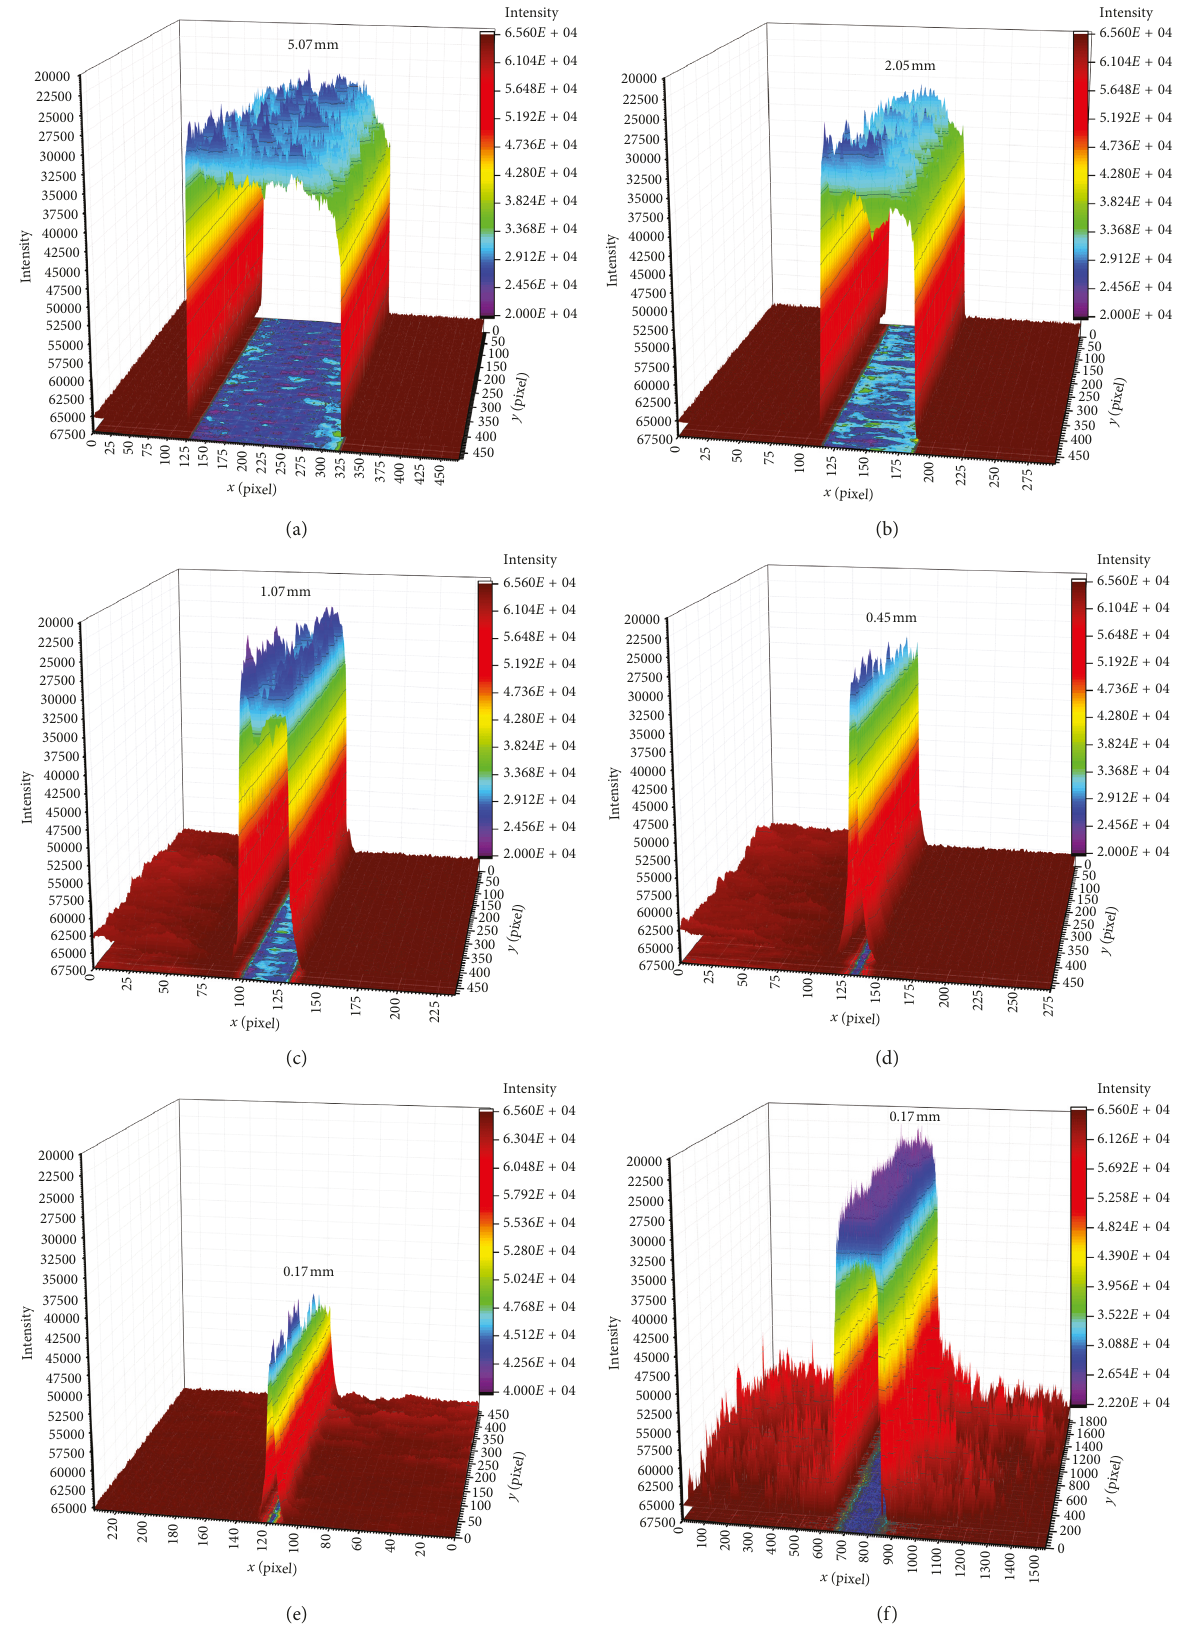
Figure 3: 3D plotting of the intensity distributions corresponding to the caliper’s gap sizes of (a) 5.07mm, (b) 2.05mm, (c) 1.07mm, (d) 0.45mm, (e) 0.17mm, and (f) 0.17mm with the